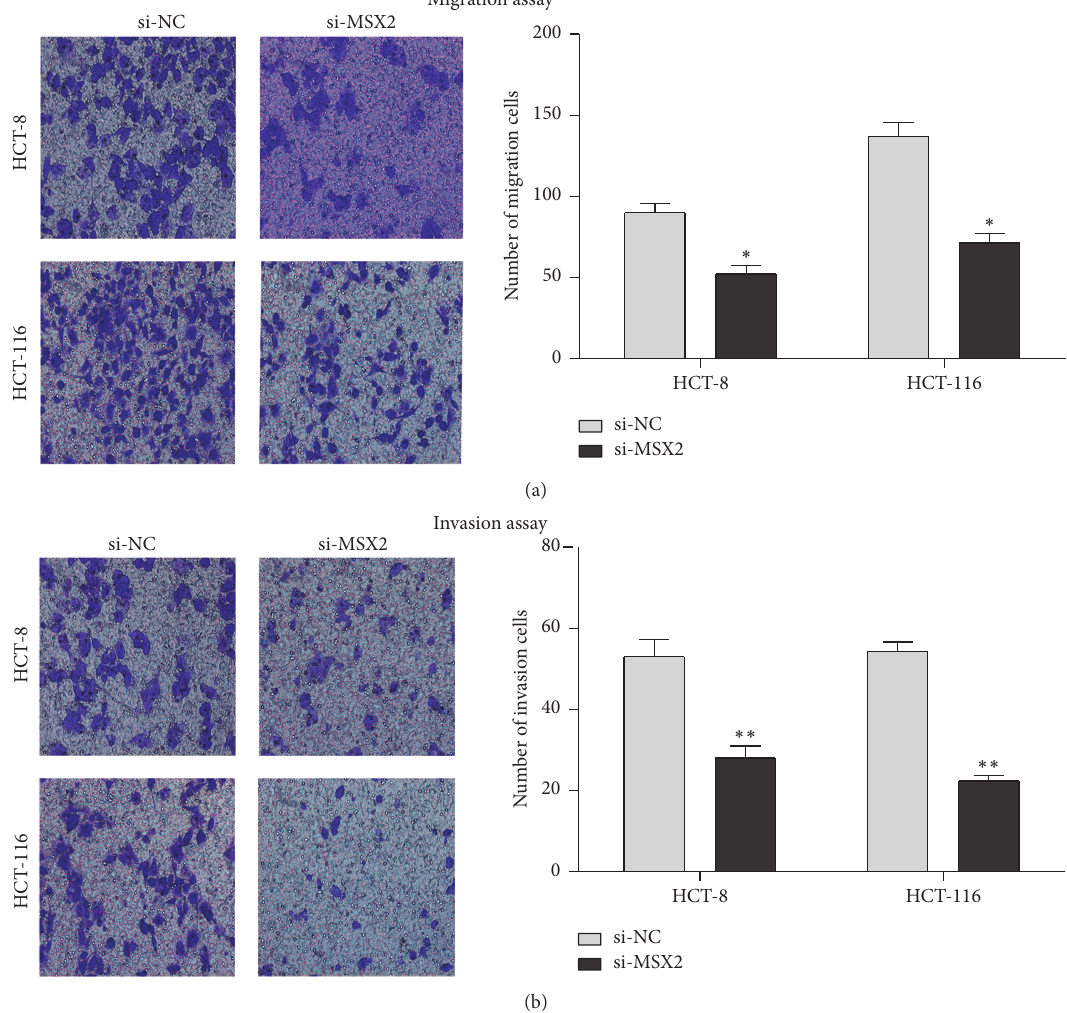
Figure 5: Knockdown of MSX2 expression suppressed the migration and invasion of CRC cell line in vitro. Representative photomicrographs of migration (chamber uncoated with matrigel) (a) and invasion (chamber coated with matrigel) (b) of HCT-8 and HCT-16 cell lines (left panel) and data summary of the number of cells that penetrated the transwell (right panel) ( ∗ 𝑃 < 0.05 , ∗∗ 𝑃 < 0.01 compared with NC). Original magnification, × 200. Data show mean ± SD of at least 3 independent